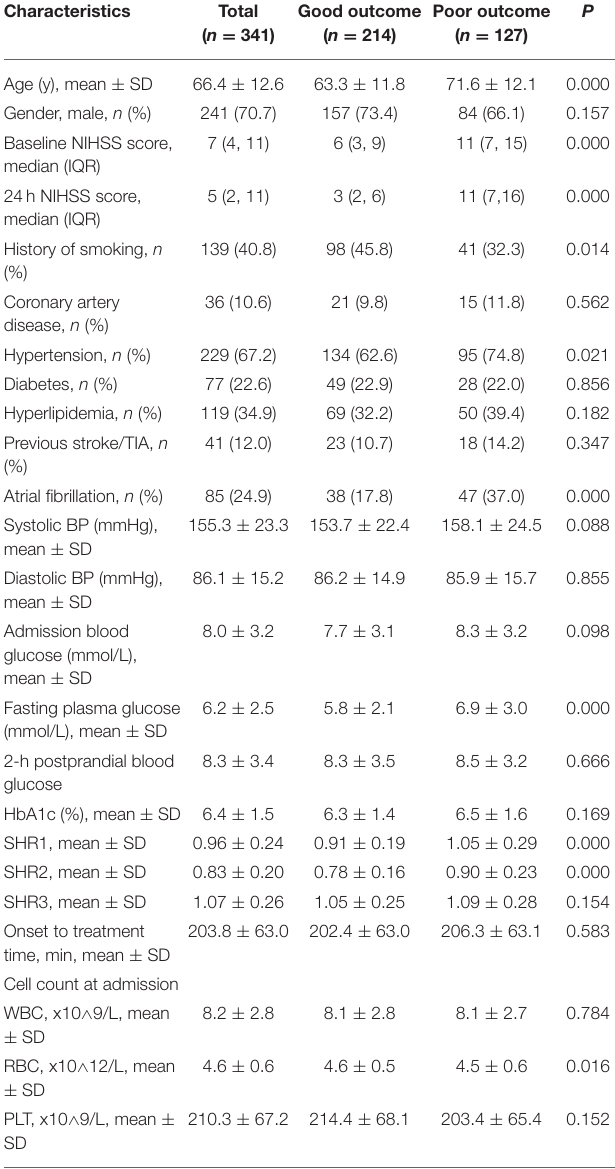
TABLE 1 | Comparison of the baseline characteristics between patients with poor and good functional outcomes.